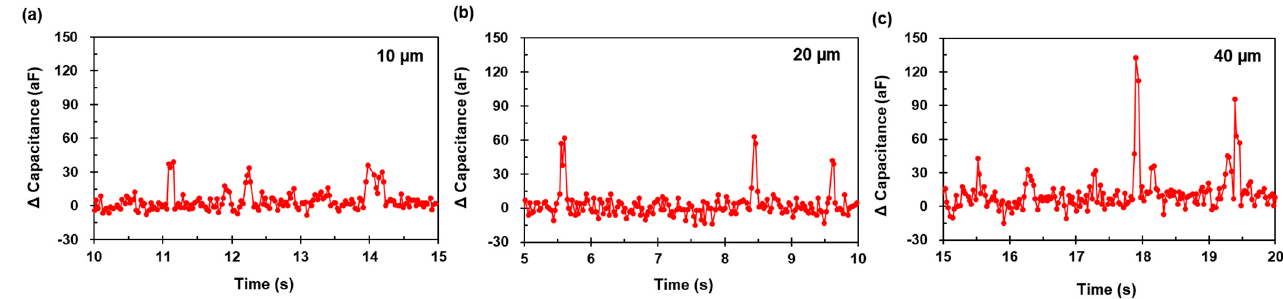
Figure 12. Close-up view of 5 s interval from measured capacitance signals for the aluminum particle sizes in ( a ) d = 10 μ m ( b ) d = 20 μ m ( c ) d = 40 μ m at 1.8 MHz.